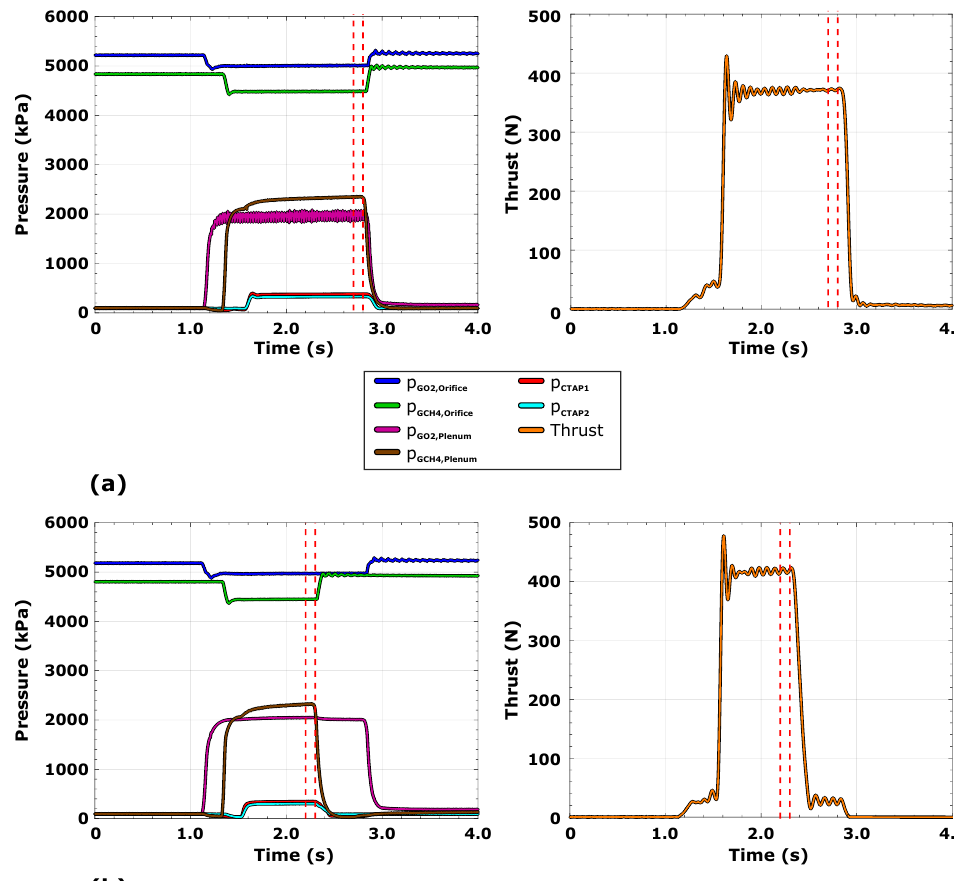
Figure 4. Example data for two tests showing both the system pressures ( left ), as well as thrust measurements ( right ) for a ( a ) 1250 ms and ( b ) 750 ms firing at the same flow condition. It should be noted that the dashed vertical lines bound the 100 ms range used for the reported average run